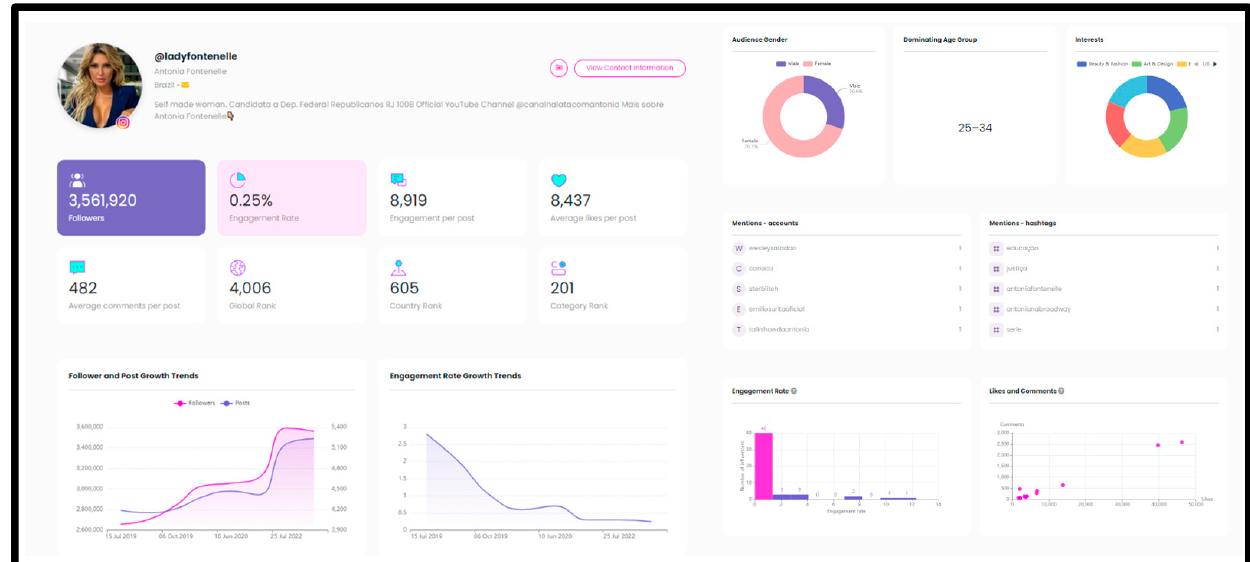
Figure 1. Instagram profile of @ladyfontenelle on Starngage (retrieved 4 October 2022). Source: Starngage.com.